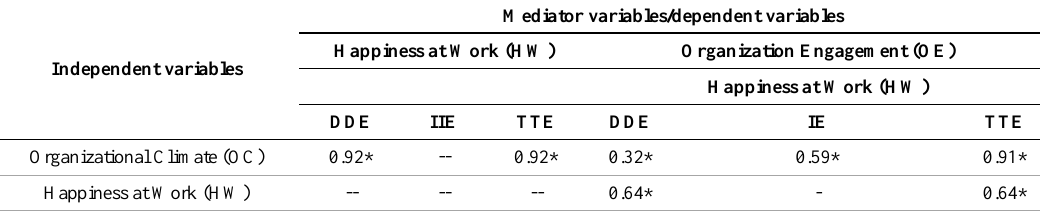
Table 1. The results of the parameter estimation of the direct effect, indirect effect, and total effect from the